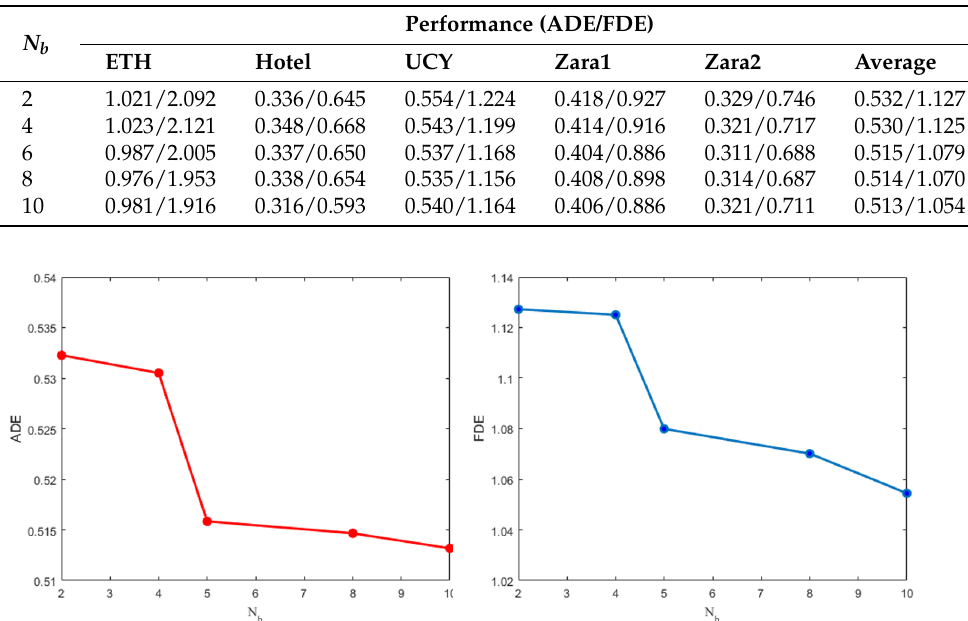
Table 4. Result comparison on ETH and UCY datasets with different numbers of blocks N b in encoder-decoder architecture. Considering the balance between performance and computation, the number of blocks layers is set to 6 in the modular transformer.